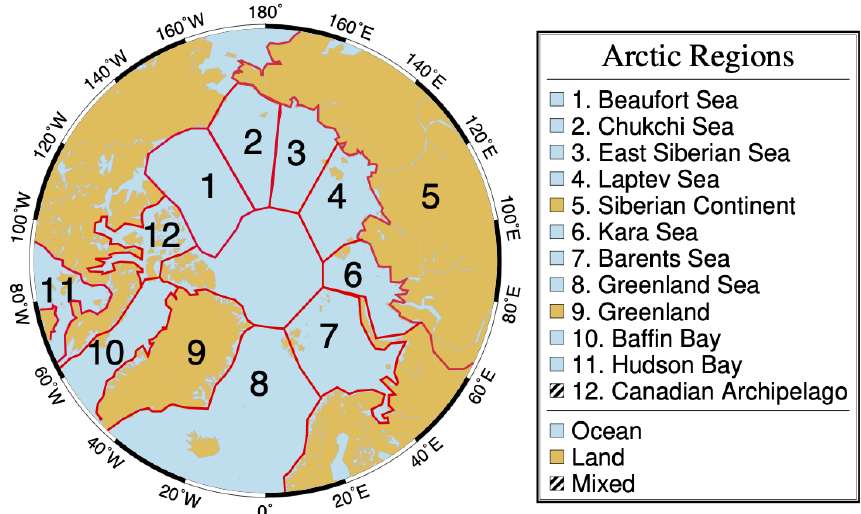
Figure B1. Definition of the Arctic climate zones, identified by distinct geophysical settings, that will be used in this study to derive local trends of R TOA , cloud properties, and forcing. The geographical subdivision follows that of Serreze and Barry (2014) and Wang and Key λ